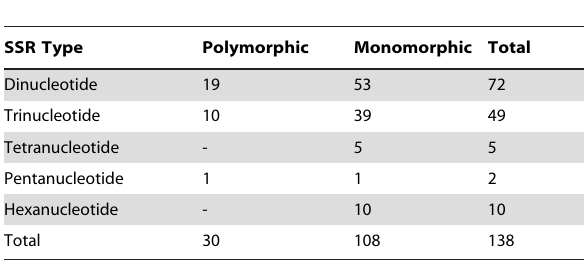
Table 3. Polymorphisms in Physalis peruviana SSR